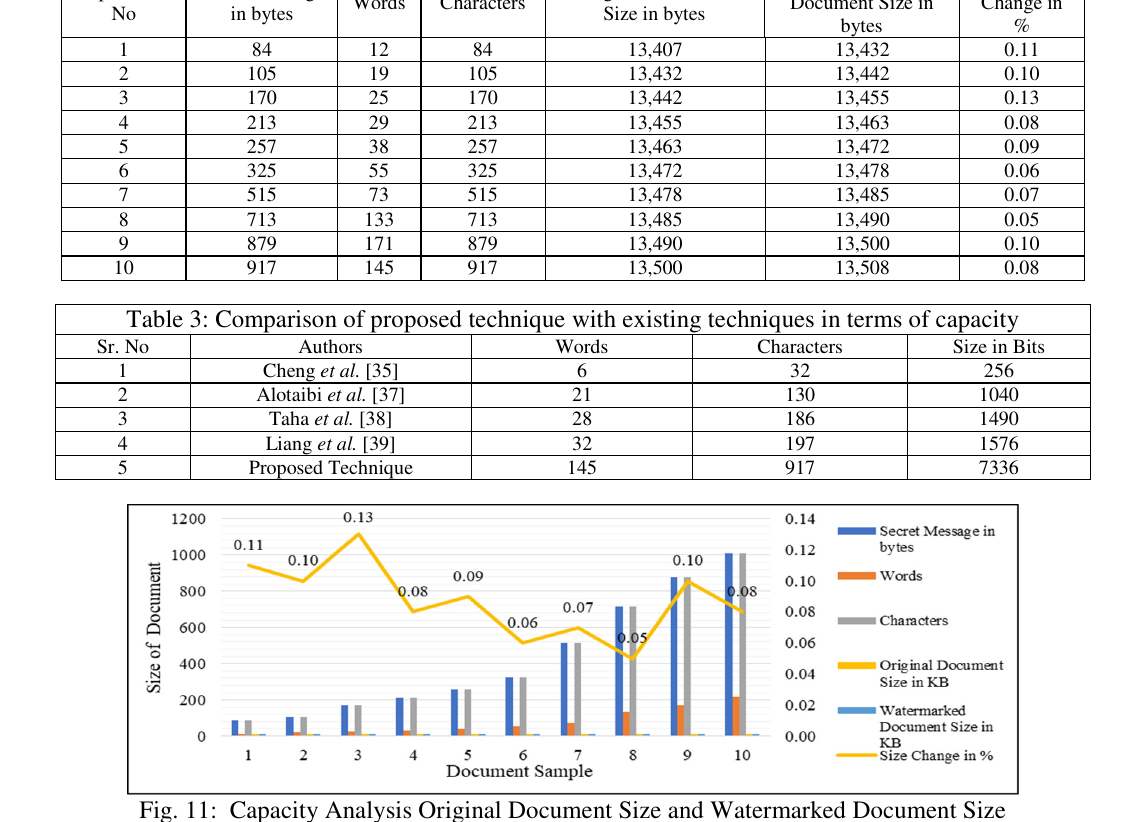
Fig. 11: Capacity Analysis Original Document Size and Watermarked Document